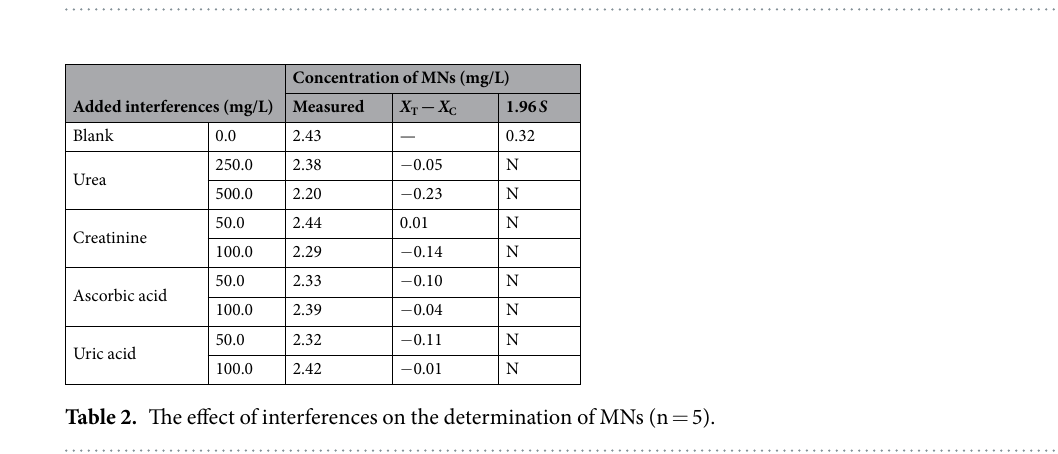
Table 1. The precisions and recoveries of MNs detected by the proposed method in spot urine samples (n = 5).